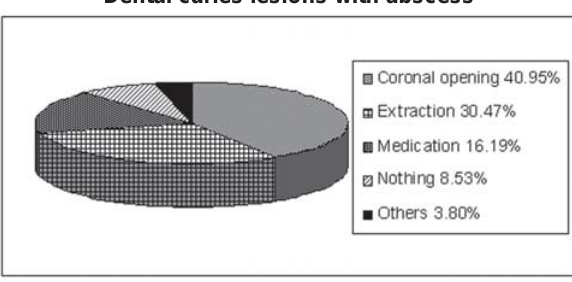
FIGURE 3- Prevalence of different treatments performed for coronal fracture, luxation, dental caries lesions without abscess and dental caries lesions with